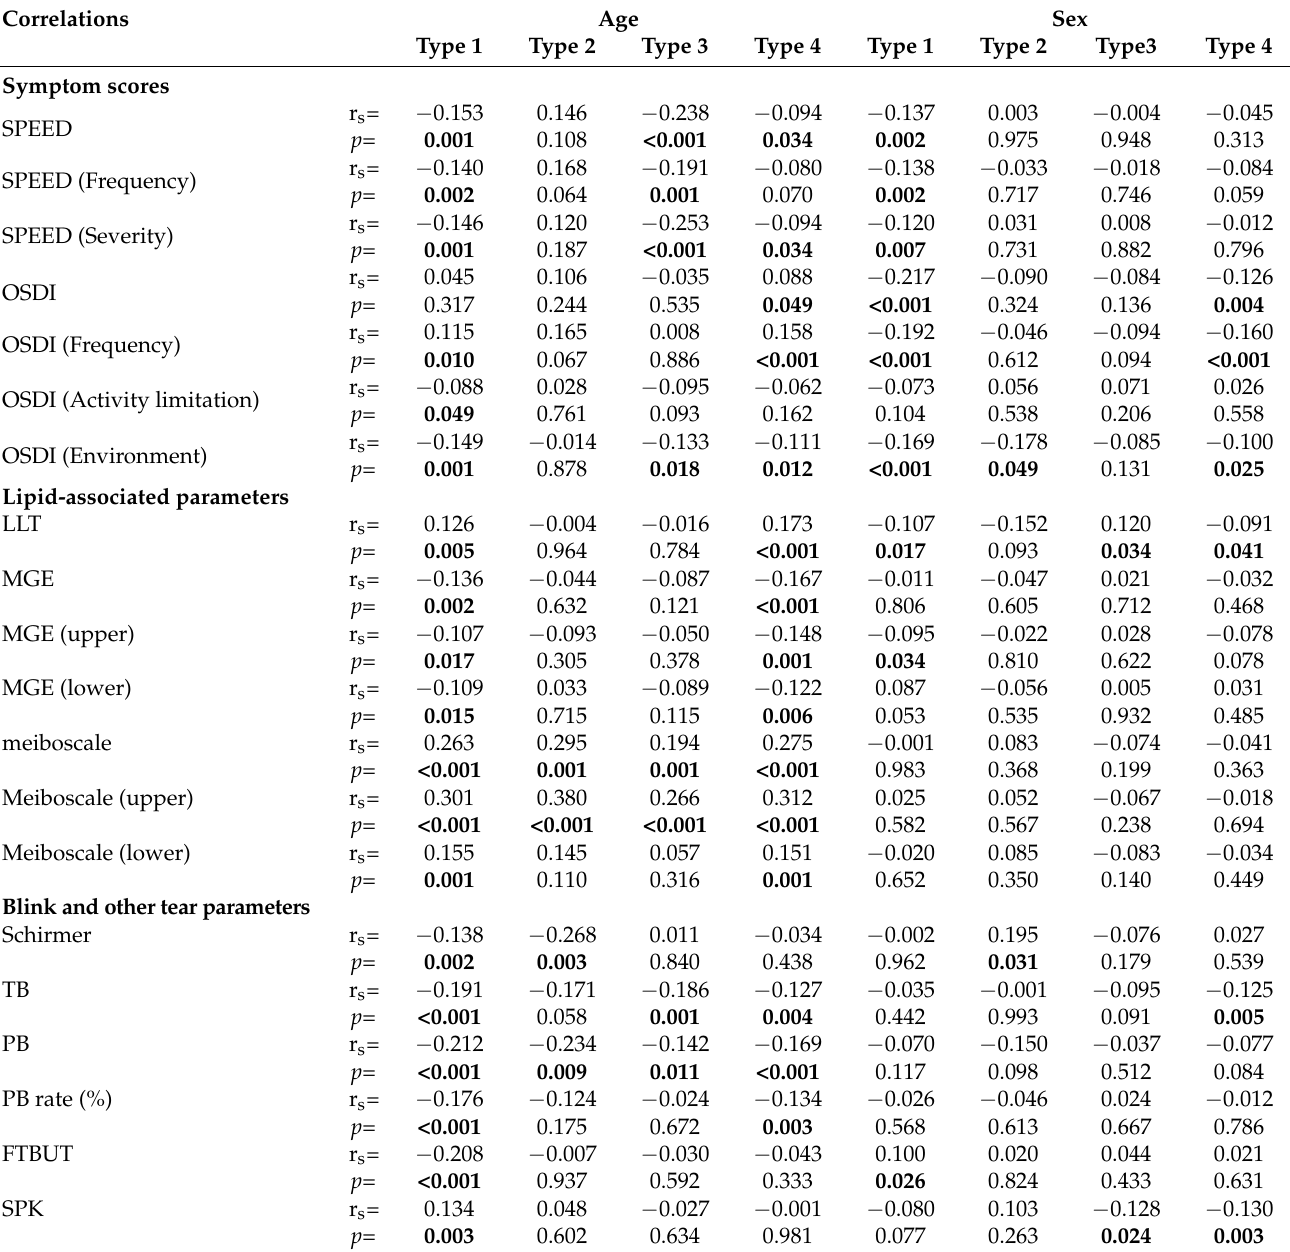
Table 4. Correlation of age and sex with subjective symptoms and lipid-associated